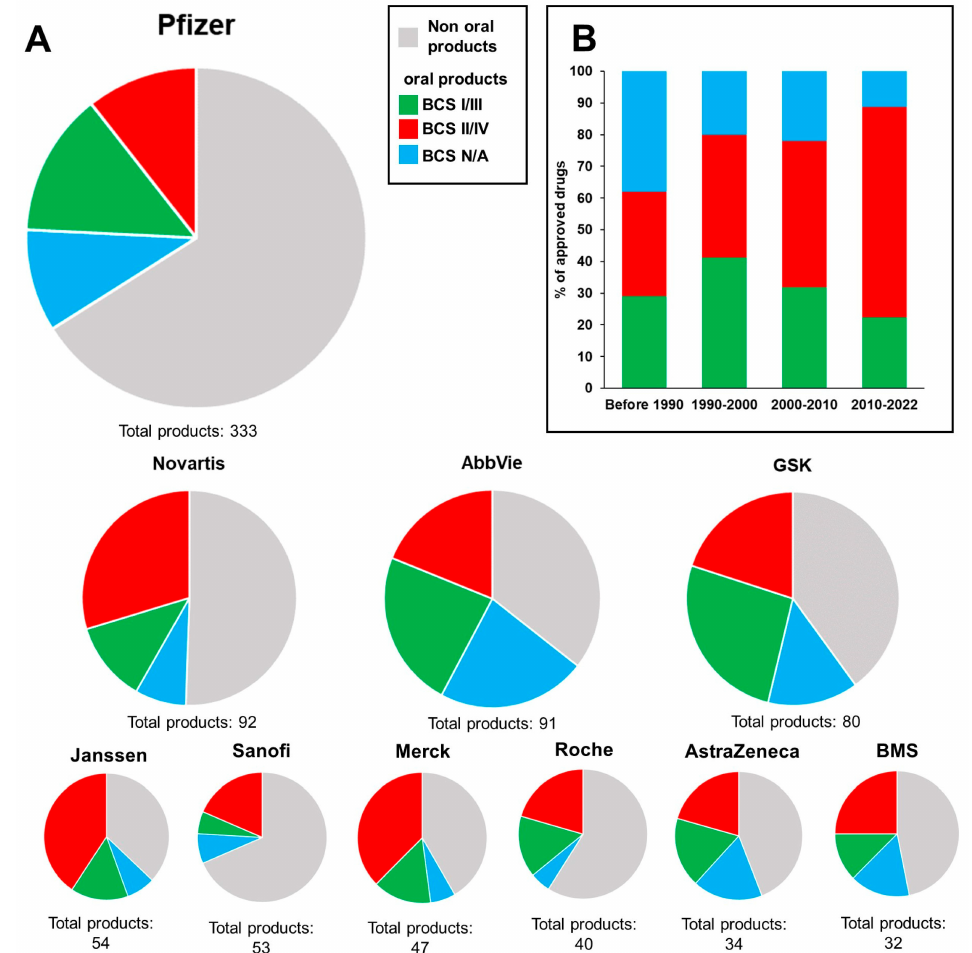
Figure 3. Overview of drug products from the 10 largest pharmaceutical companies (Table 1). ( A ) Drug product portfolios, in which products are divided into non-oral and oral products. Oral products are divided into high-solubility (BCS class I/III) and low-solubility (BCS II/IV) drugs. ( B ) BCS classes of oral drugs from the 10 pharmaceutical companies by their year of approval. BCS class I/III—green; BCS class II/IV—red; BCS class not available